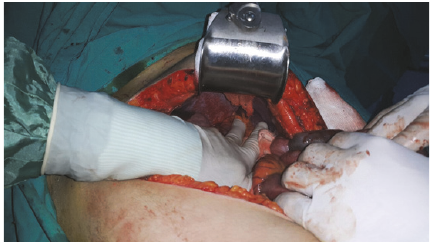
Figure 3: An intraoperative image of diaphragmatic